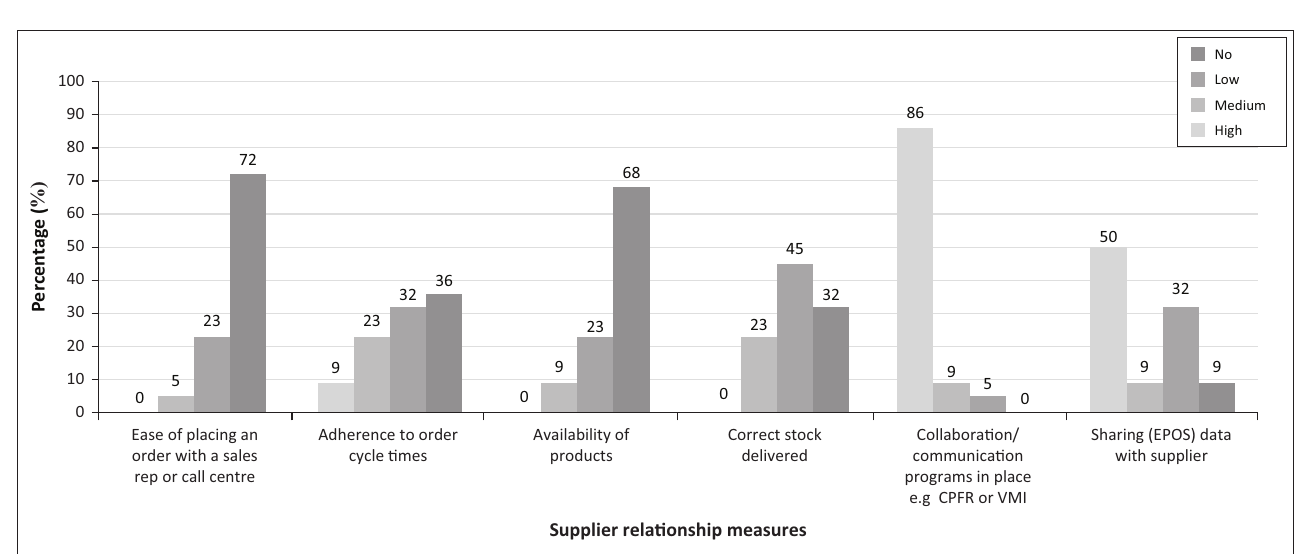
FIGURE 4: Retail and operations process modelling (respondents’ rating in % ).